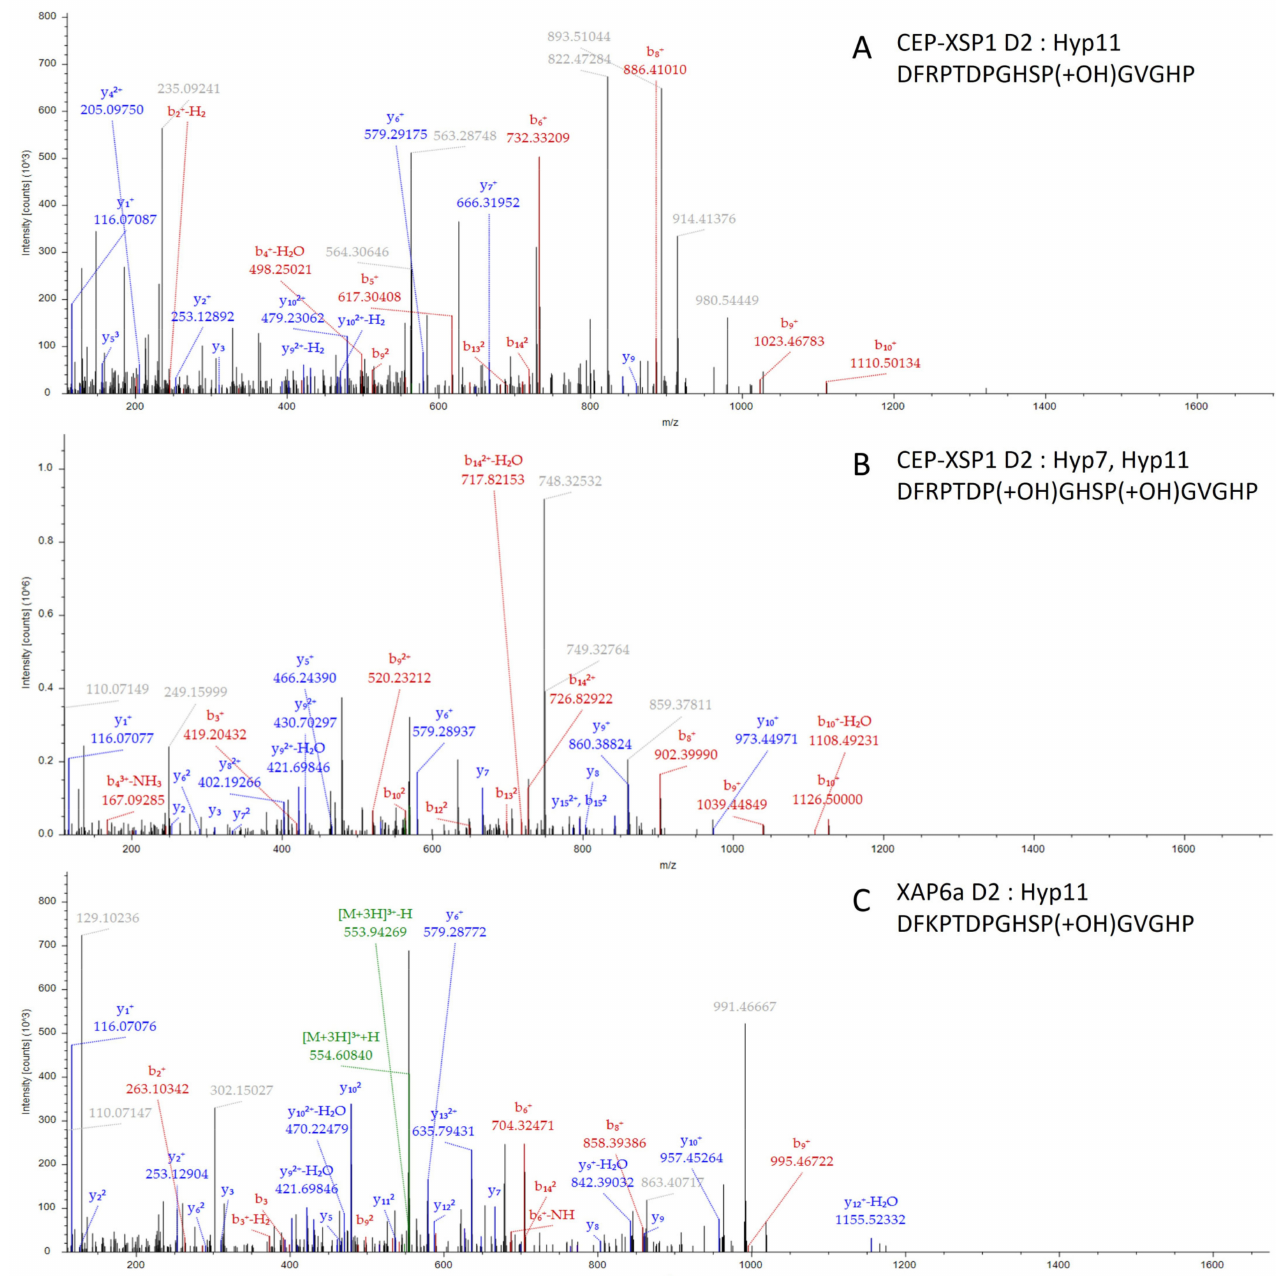
Figure 3. MS/MS spectra of CEP-XSP1 D2 (Hyp11), CEP-XSP1 D2 (Hyp7, Hyp11), and XAP6a (Hyp11) identified in peptide extract from soybean xylem sap: ( A ) MS/MS spectrum of CEP- XSP1 D2 peptide with hydroxylation at P11 (m/z 563.59784, z = 3); ( B ) MS/MS spectrum of CEP- XSP1 D2 peptide with hydroxylation at P7 and P11 (m/z 568.92926, z = 3); ( C ) MS/MS spectrum of XAP6a D2 peptide with hydroxylation at P11 (m/z 554.26093, z =